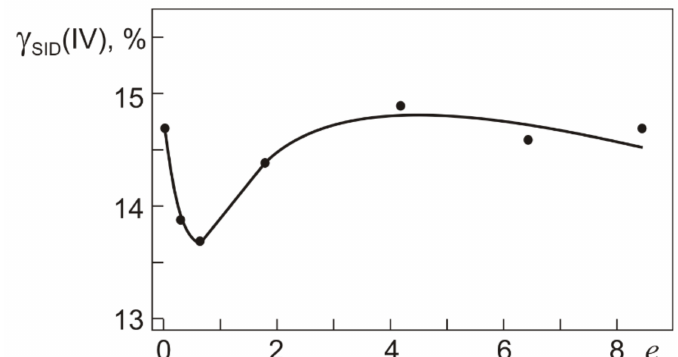
Figure 10. Total reversible inelastic strain γ SID (IV) recovered by Ti 49.8 Ni 50.2 after torsion with τ = τ 0.3 (IV) (295 K) and heating (500 K) at di ff erent true strains e specified in warm abc pressing.